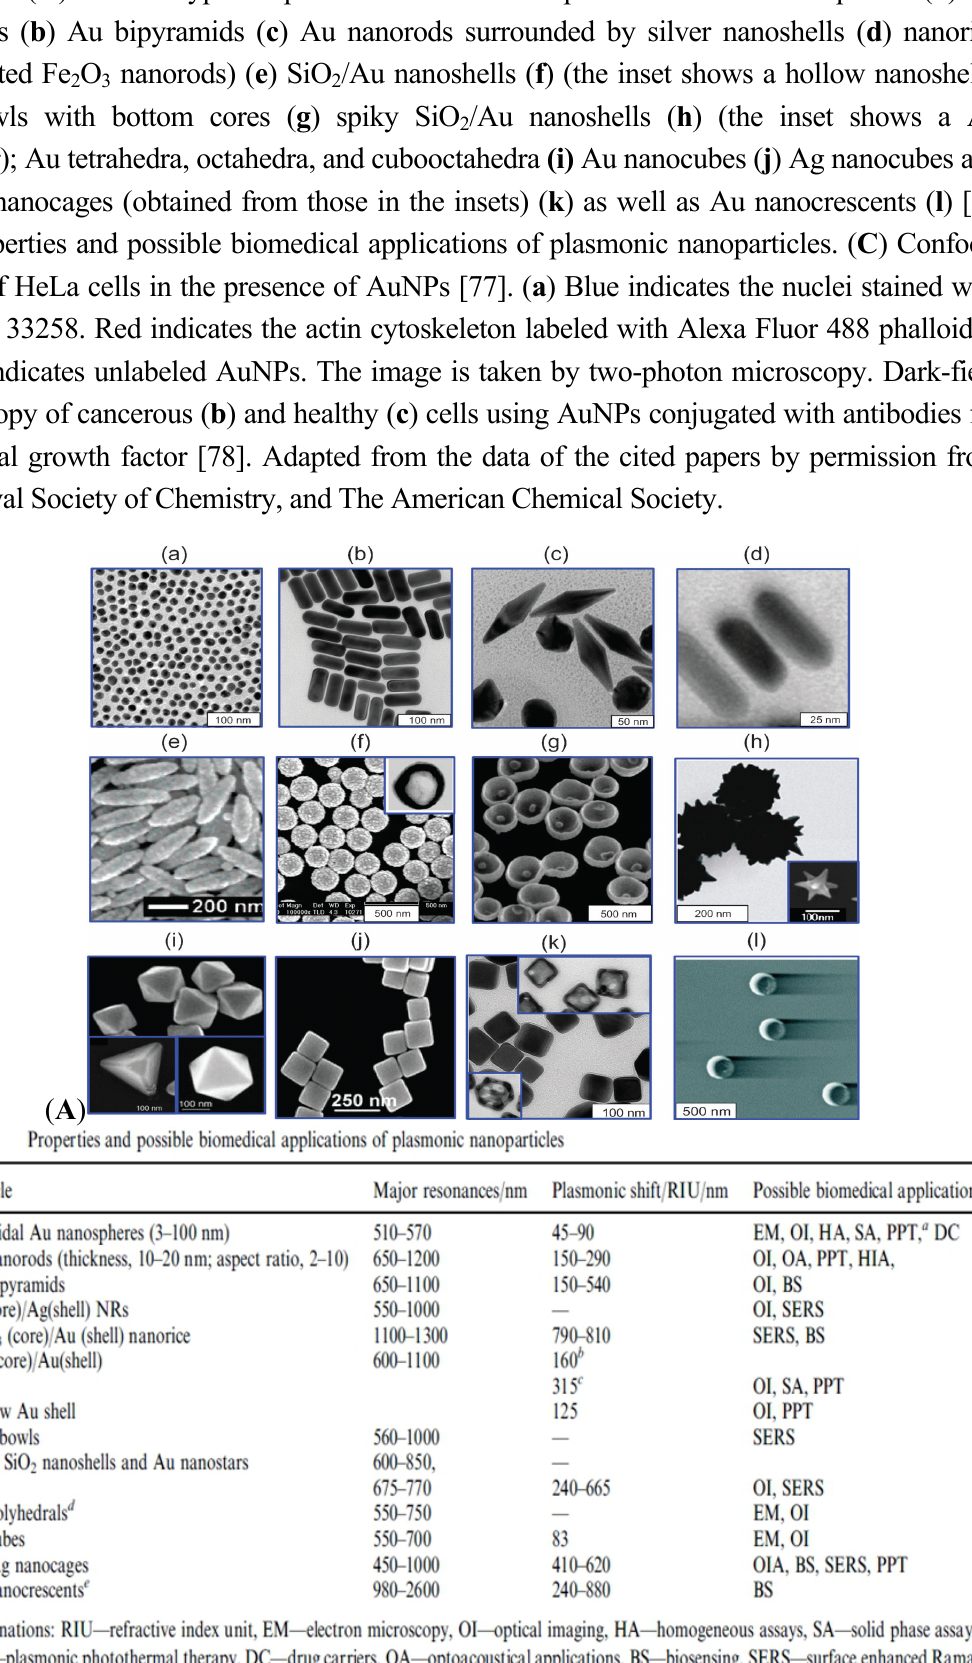
Figure 4. ( A ) Various types of plasmon-resonant nanoparticles: 16 nm nanospheres ( a )